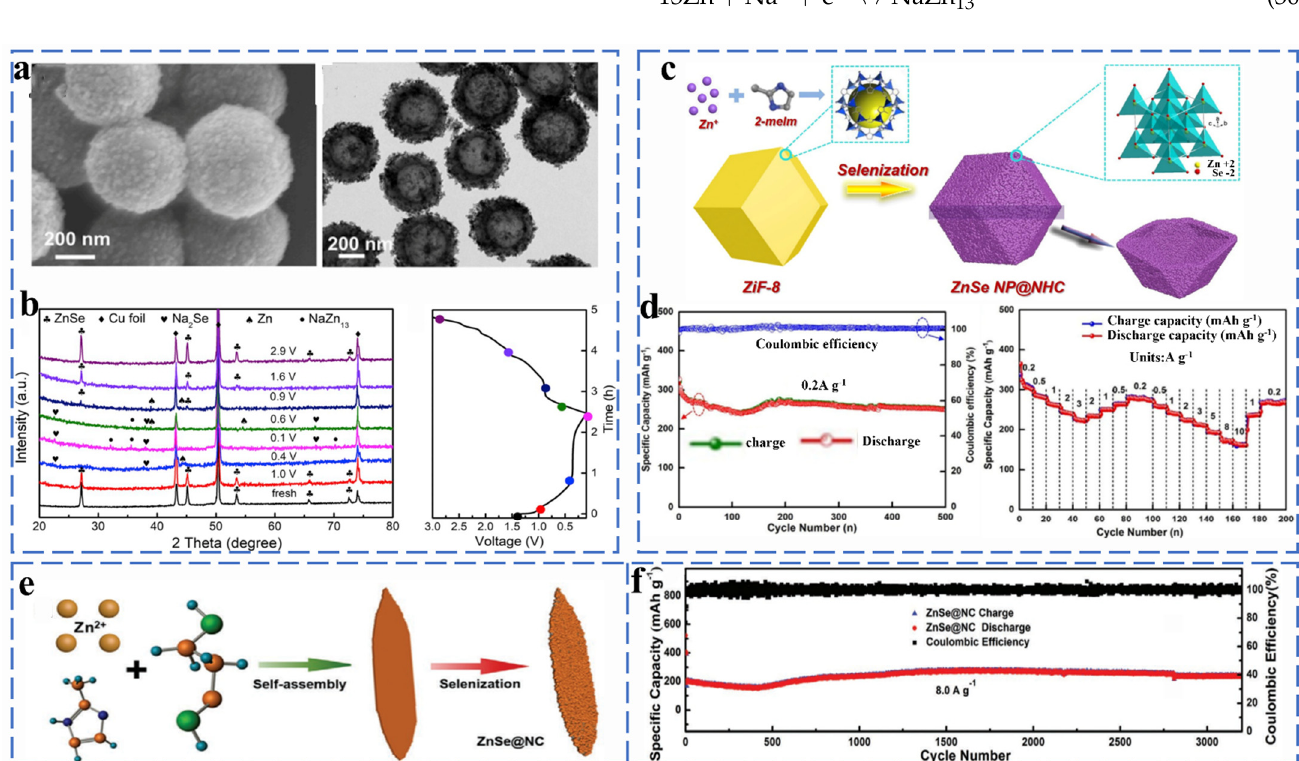
Figure 8. ( a ) SEM and TEM image of ZnSe@HCNs. ( b ) Ex situ XRD analysis of the ZnSe@HCNs electrodes at different charge/discharge states and corresponding charge/discharge curve. Reprinted with permission from Ref. [60]. Copyright 2019 copyright. Zheng, F. ( c ) Schematic illustration for the fabrication processes and structure of ZnSe NP@NHC nanocomposite. ( d ) Cycling performances and the corresponding Coulombic efficiencies and rate performance. Reprinted with per-